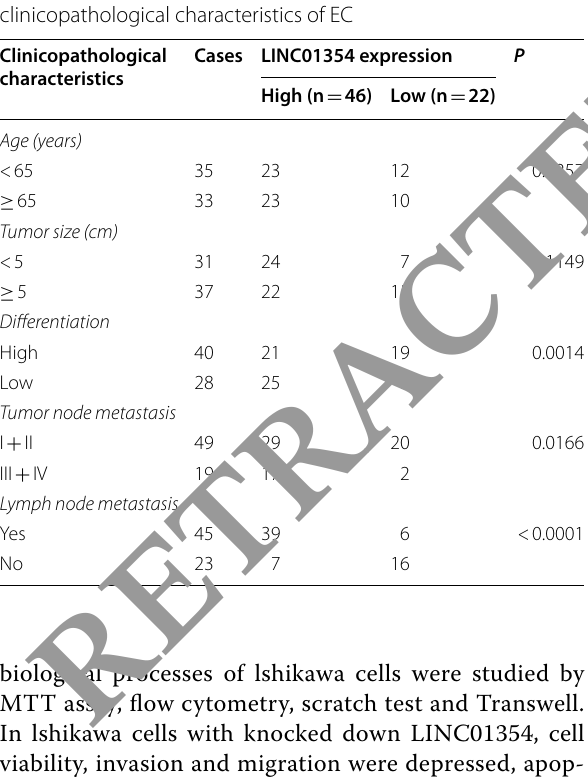
Fig. 1 Increased LINC01354 level is measured in EC. a LINC01354 expression was increased in EC tissues versus normal tissues detected by RT-qPCR ( n 68); b LINC01354 expression was increased in EC cell lines versus NE cells detected by RT-qPCR ( N = mean standard deviation ±